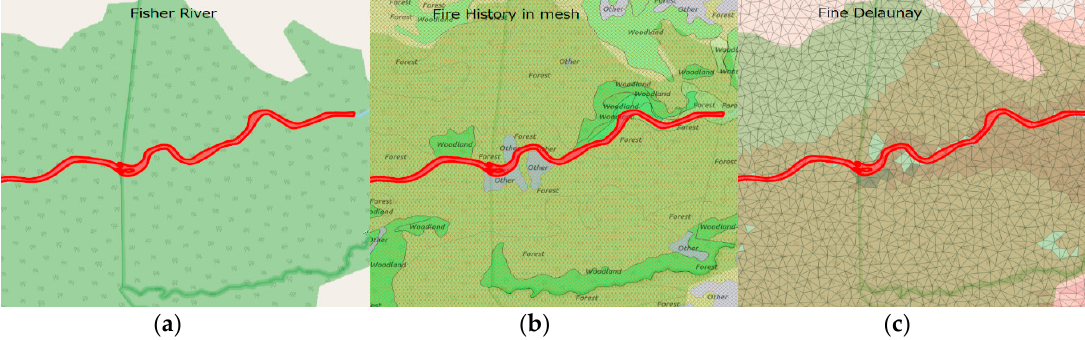
Figure 5. Comparison from left to right, ( a ) Fisher River in red, ( b ) Fire History in red mesh, ( c ) Delaunay in red triangle polygons.